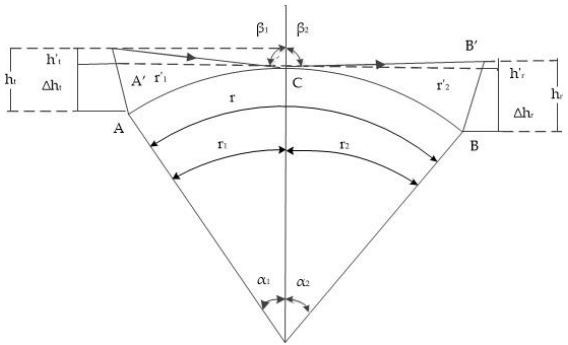
Figure 1. The ray geometry of the spherical sea surface.